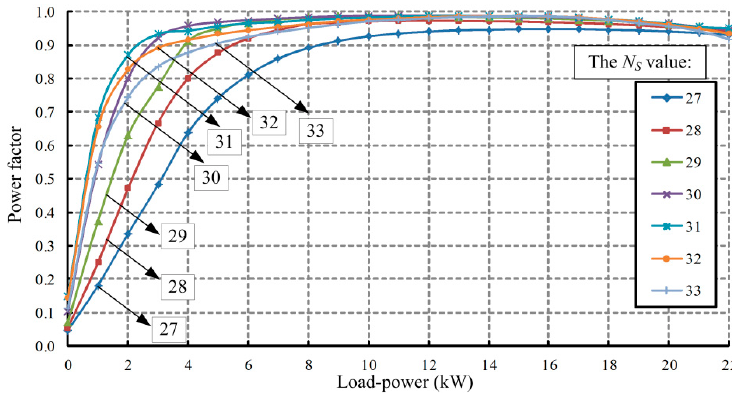
Figure 8. The PF varies with the N S .